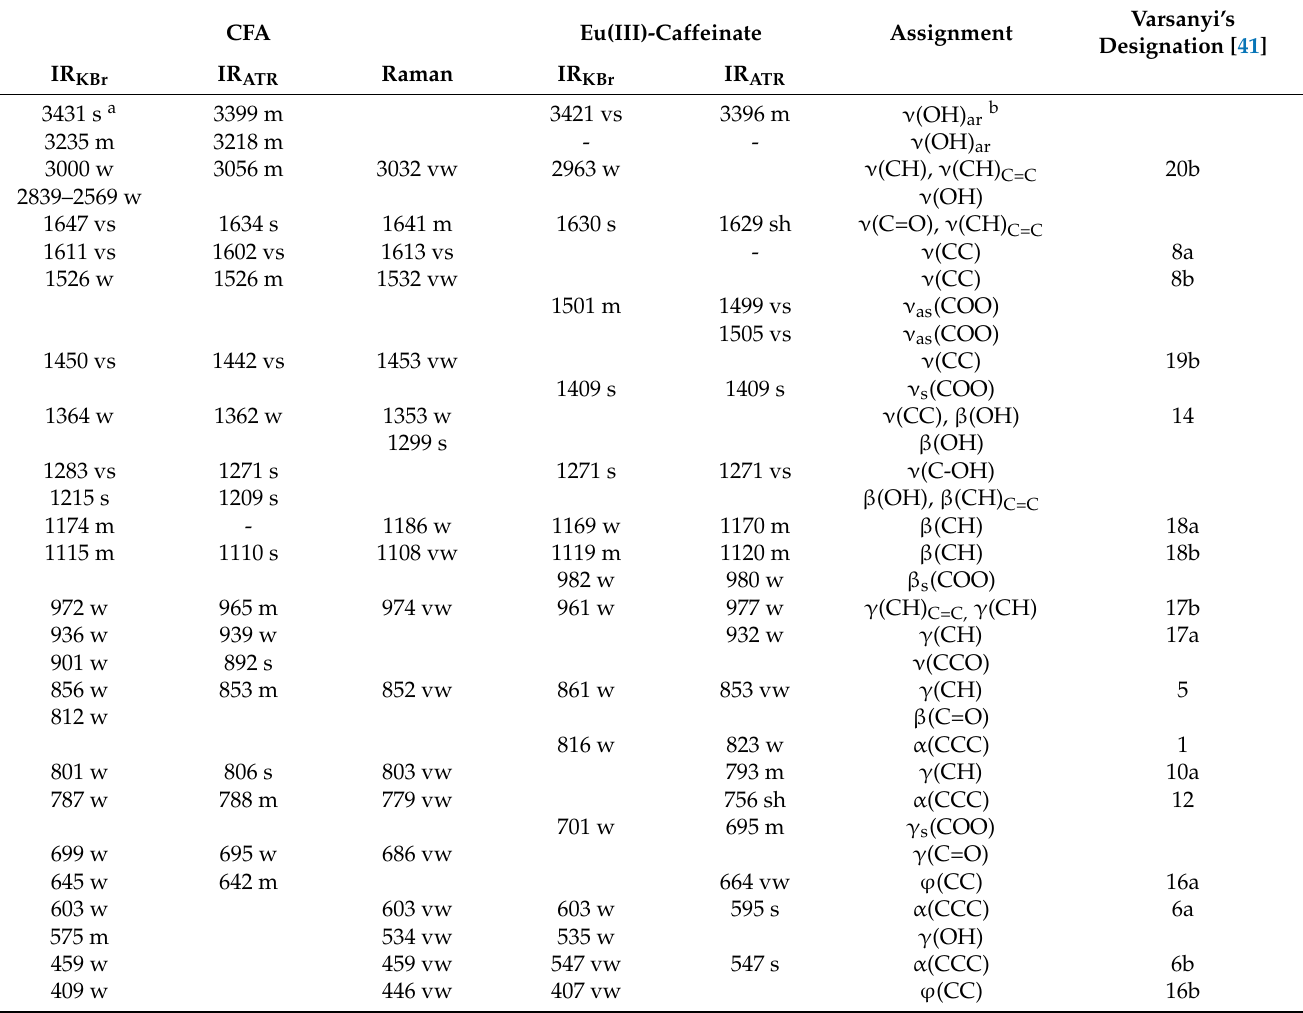
Table 1. The wavenumbers (cm − 1 ), intensities and assignments of bands observed in the experimental FT-IR (KBr and ATR) and FT-Raman spectra of CFA and